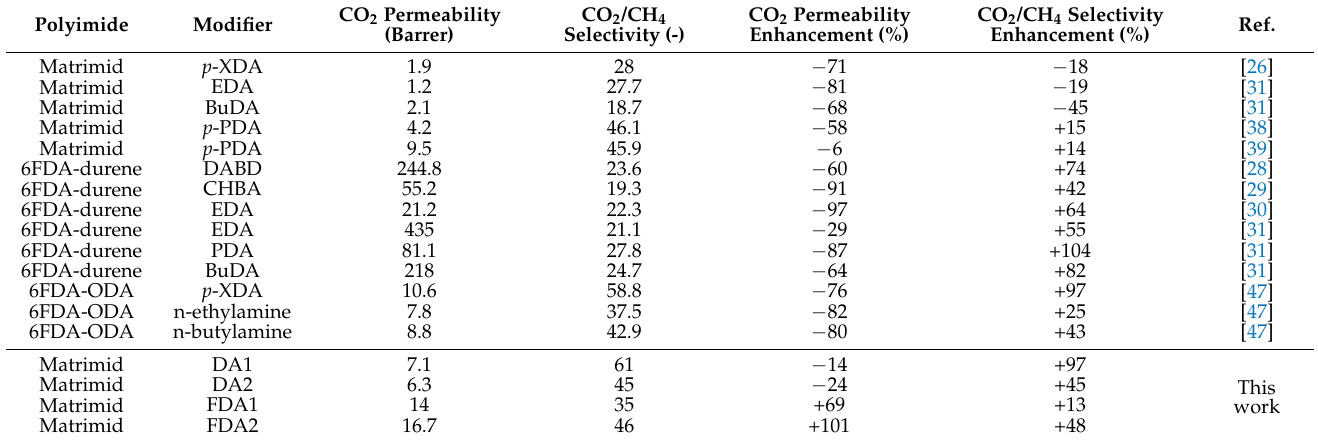
Table 3. Comparison of CO 2 /CH 4 separation performance of amino-modified polyimide membranes.